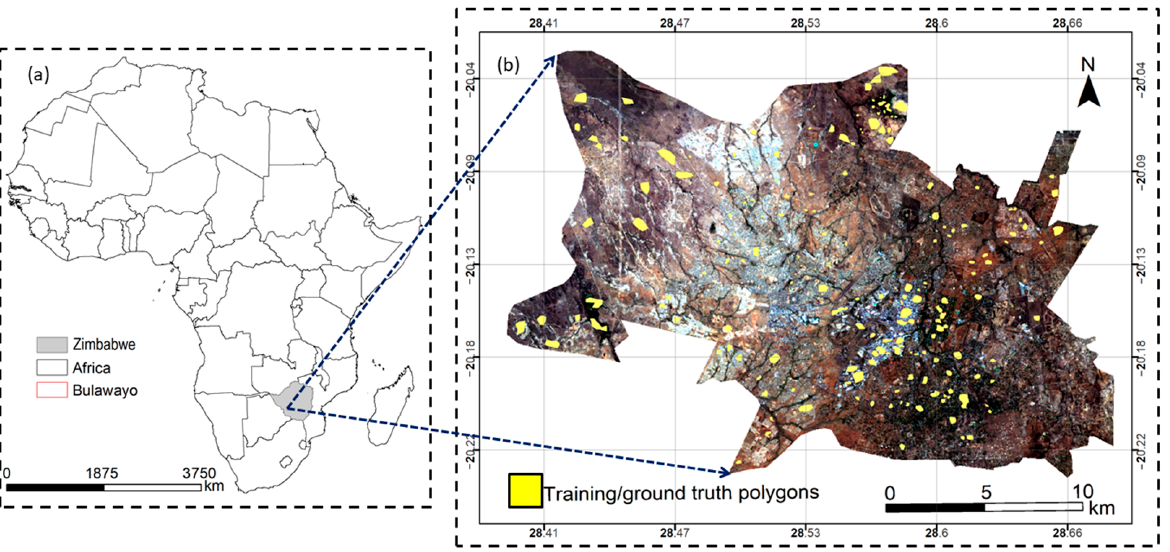
Figure 1. Map of Africa showing the location of Zimbabwe and Bulawayo ( a ) and map of Bulawayo showing distribution of training areas ( b )—training sites not visible.